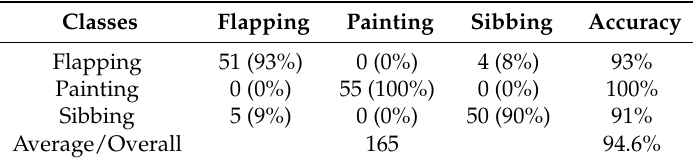
Table 1. Classification result of autism behavior